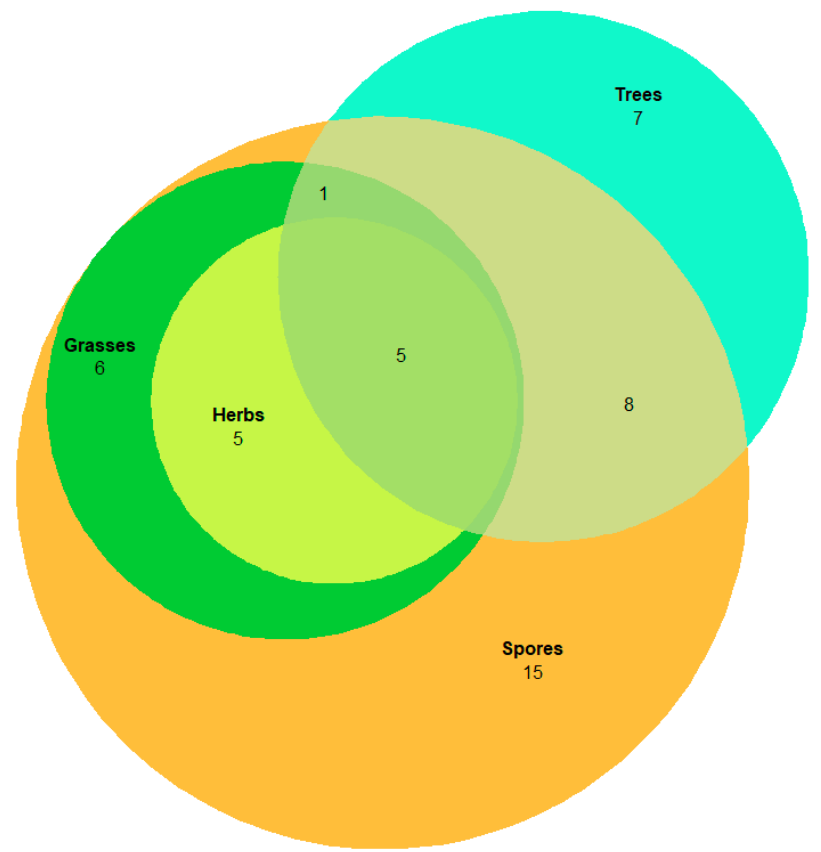
Figure 3. Euler diagram depicting days of co-occurring high concentrations of PBAP.